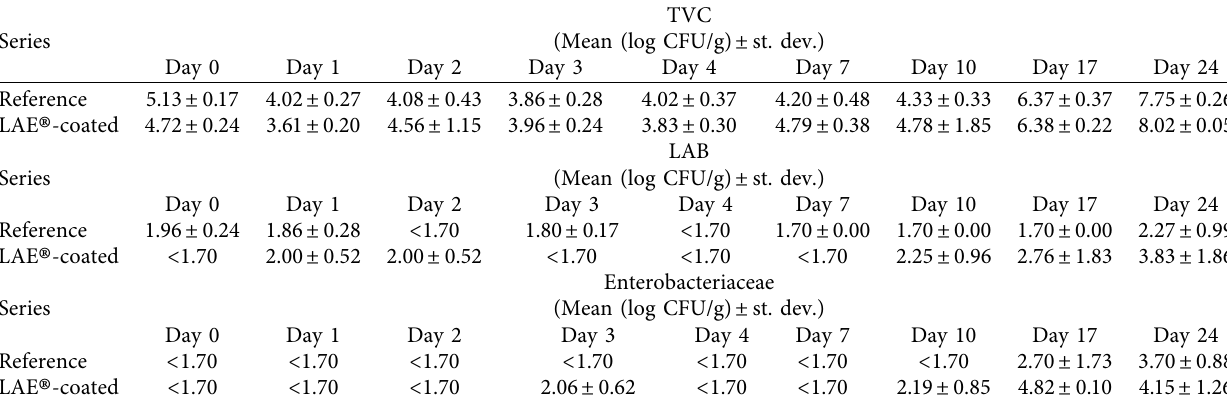
Table 2: Mean TVC, LAB, and Enterobacteriaceae counts obtained in reference and LAE ® -coated pork samples during the trial. Series